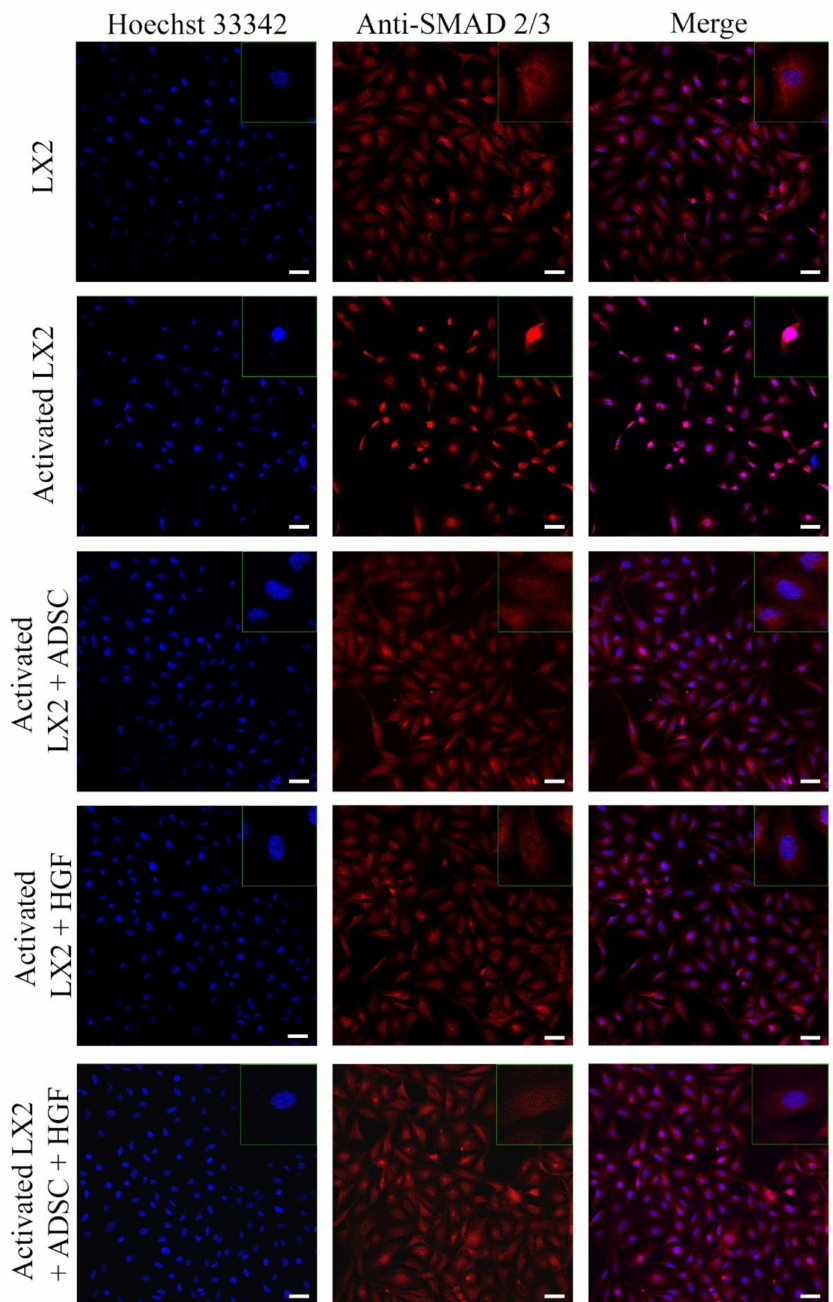
Figure 4. Immunofluorescence staining of SMAD 2/3 (antibody conjugated with AF-546, green), nuclei of the cells stained with Hoechst 33342 (blue), in the following conditions: LX2, activated LX2 (induced with TGF- β 1), activated LX2 + ADSC (activated LX2 cocultured with ADSCs), activated LX2 + HGF (activated LX2 treated with HGF), activated LX2 + ADSC + HGF (activated LX2 cocultured with ADSC, treated with HGF); scale bar: 50 µ